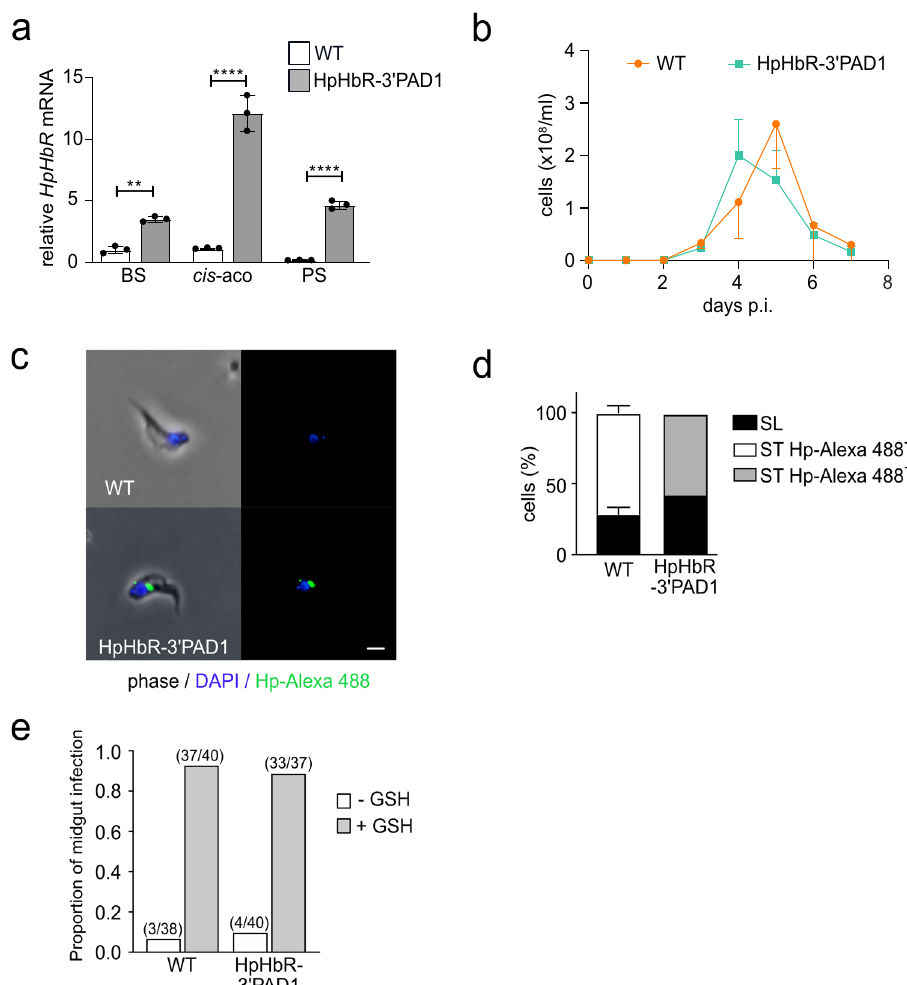
Fig. 3 | Arti fi cial expression of HpHbR in stumpy form does not interfere with lifecycleprogression.a TheexpressionofHpHbRwasassessedasin( b )intheWT T. b. brucei and HpHbR-3 ’ PAD1 trypanosomes. RNA was extracted from the BS, 2h afterdifferentiationwastriggered by cis -aconitate ( cis -aco)and the procyclicstage (PS). Tukey ’ s multiple comparison test, n=3. Error bars indicate ±SD. b In vivo infectivity of WT T. b. brucei and HpHbR-3 ’ PAD1 cells was evaluated by infecting mice with 1×10 4 cells. The parasitemia was counted daily till day 7. c A repre- sentative WT T. b. brucei and HpHbR-3 ’ PAD1 cells were isolated from the blood of